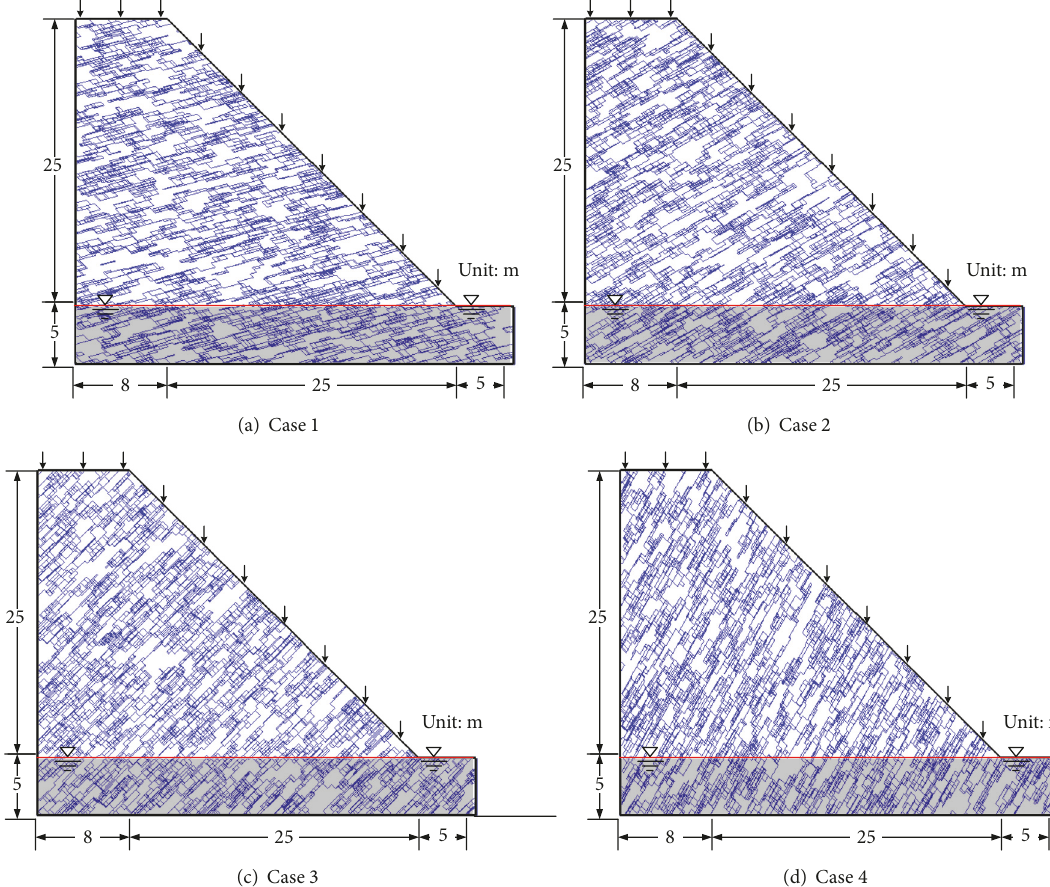
Figure 11: Numerical realizations of two fracture systems in a fractured rock slope under rainfall condition: (a) dip of 15 degrees; (b) dip of 30 degrees; (c) dip of 45 degrees; (d) dip of 60